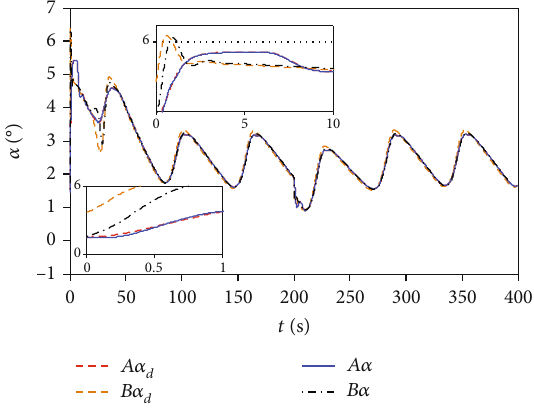
Figure 6: Tracking curves of